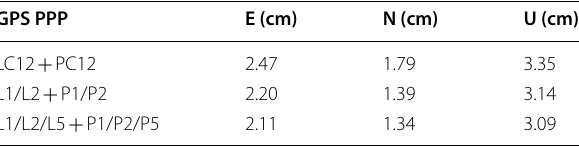
Table 2 Averaged RMS values for E, N, and U components for different GPS PPP